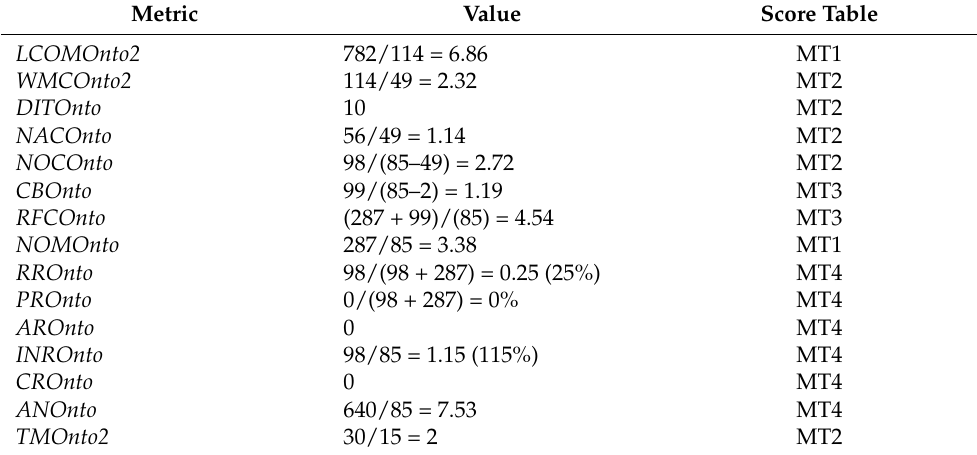
Table 4. Calculated ontology metrics based on the corrected OQuaRE